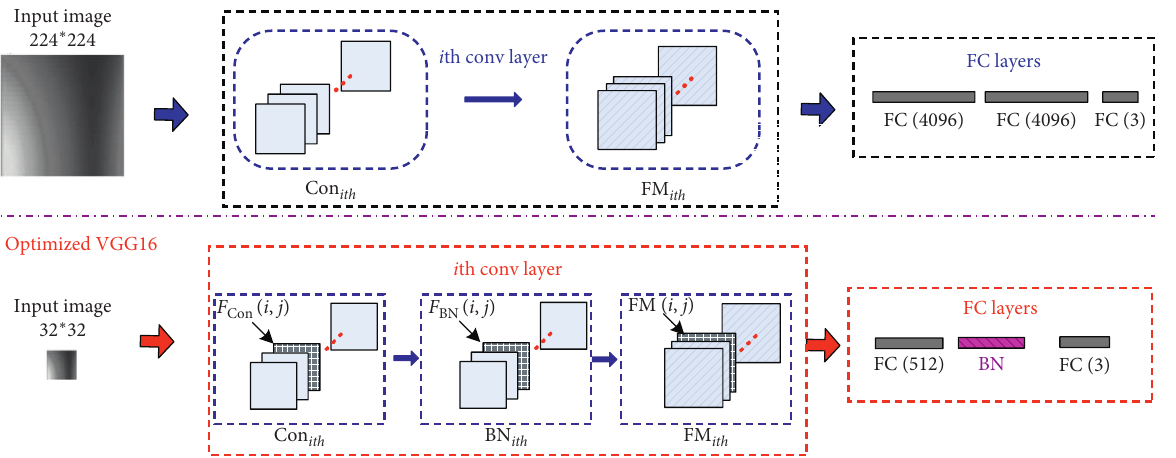
Figure 9: Comparison between baseline and pruned VGG16. Table 3: Pretrained network parameters.